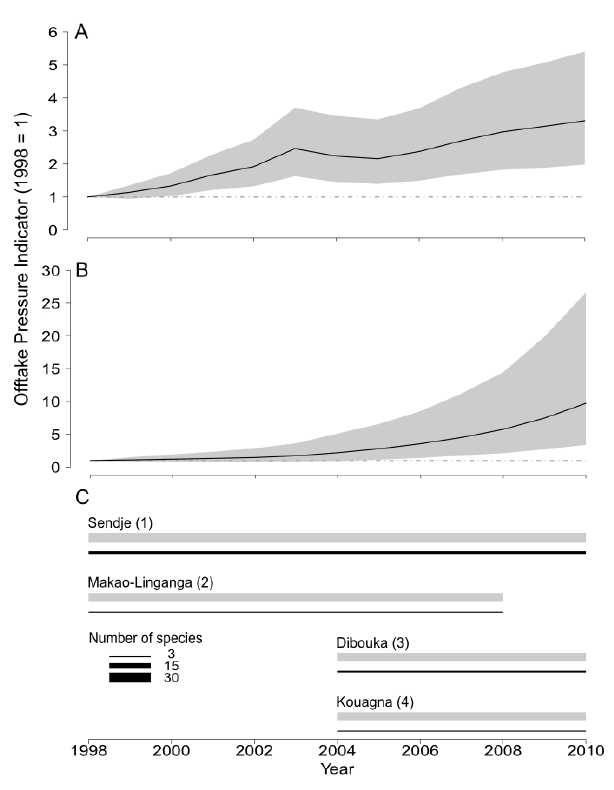
Fig. 3 . Offtake pressure indicator for mammals (A) and birds (B) in Central Africa and the distribution of time-series data at the four sites listed in Table 1 (C). The indicator is set to 1 in the first year for which data were available (dotted horizontal line). Shading (A and B) represents ± 95% confidence intervals generated with 1000 bootstrap replicates. Width of bars (C) represents the number of mammal (gray) and bird (black) species sampled at four sites (numbers refer to sample sites shown in Fig. 1 and Table